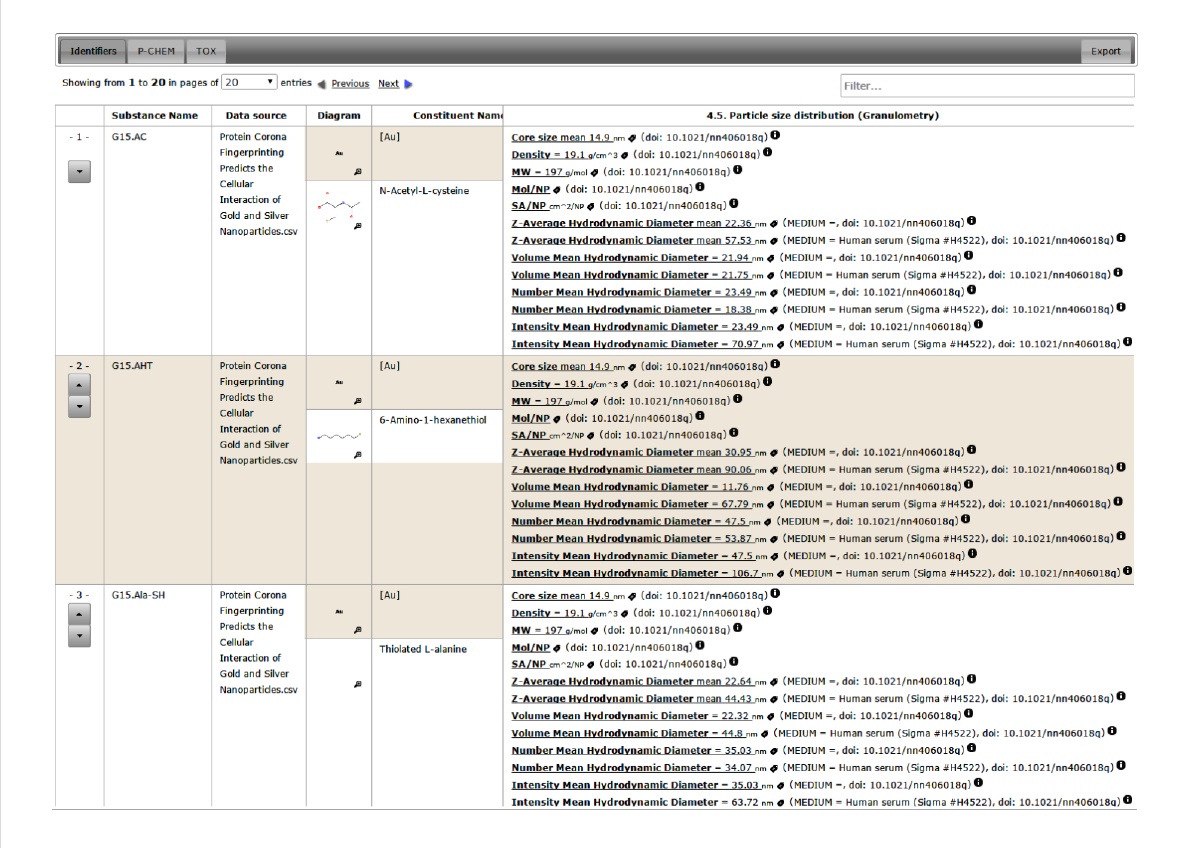
Figure 10: Screenshot of the bundle view with the Protein Corona data set. In addition to the Substance API, which allows one to retrieve study data for a single NM as in Figure 5, the bundle API provides efficient means to retrieve information about a set of NMs.